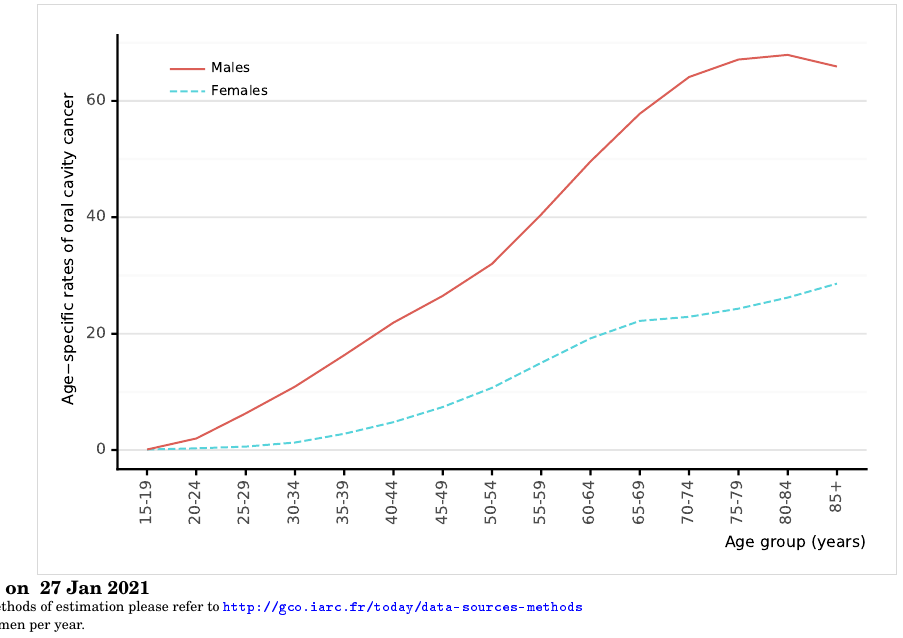
Figure 42: Age-specific incidence rates of oral cavity cancer in India (estimates for 2020)